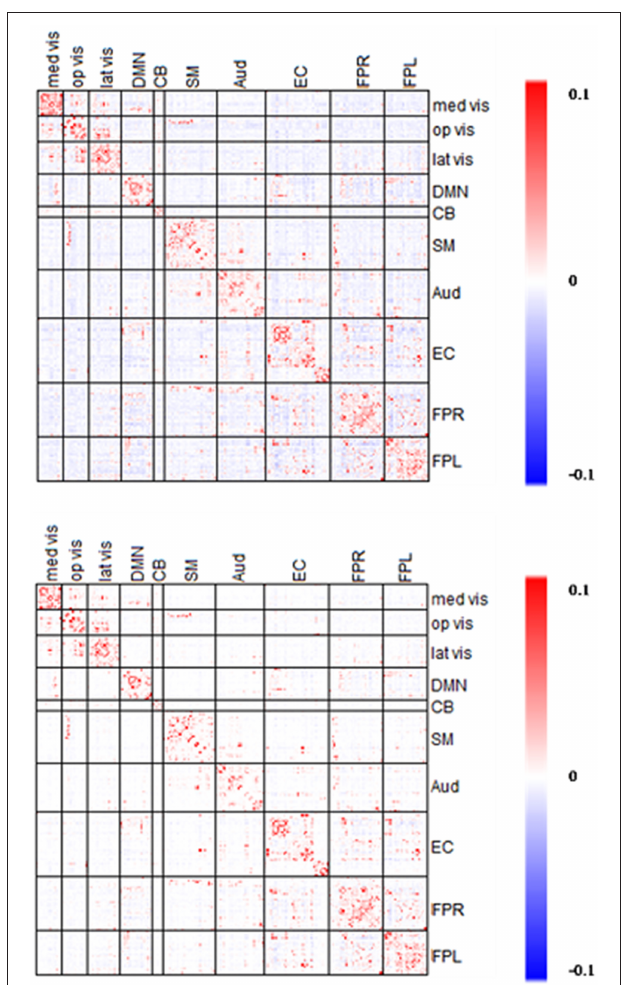
FIGURE 12 | Averaged edgewise λ * platu - and λ * 0.45 -based Partial Correlation matrices. The symmetric 232 232 partial correlation matrices × based on λ * platu (top) and λ * 0.45 (bottom) . Red indicates the positive edges and blue indicates the negative edges.